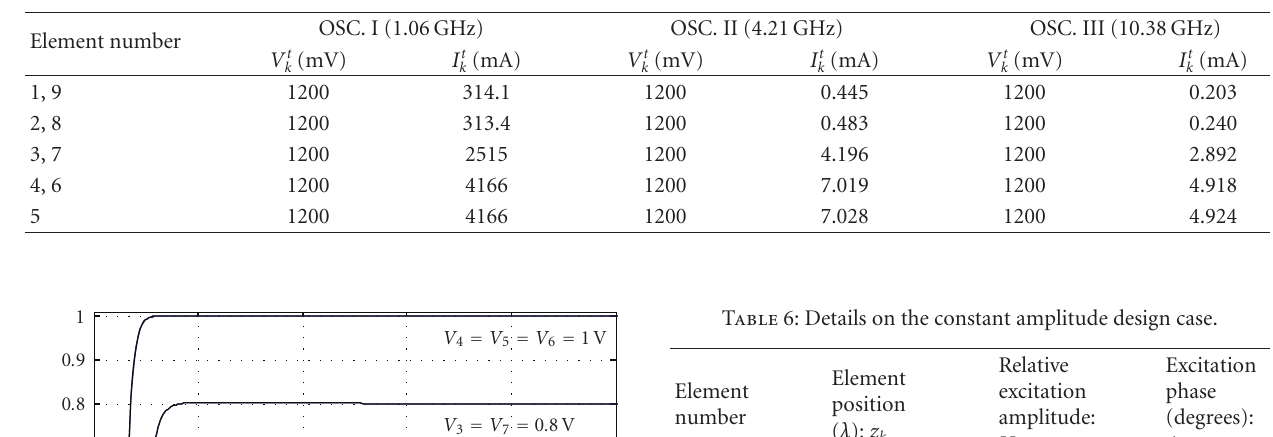
Table 5: The tuning parameters for the constant phase design case.